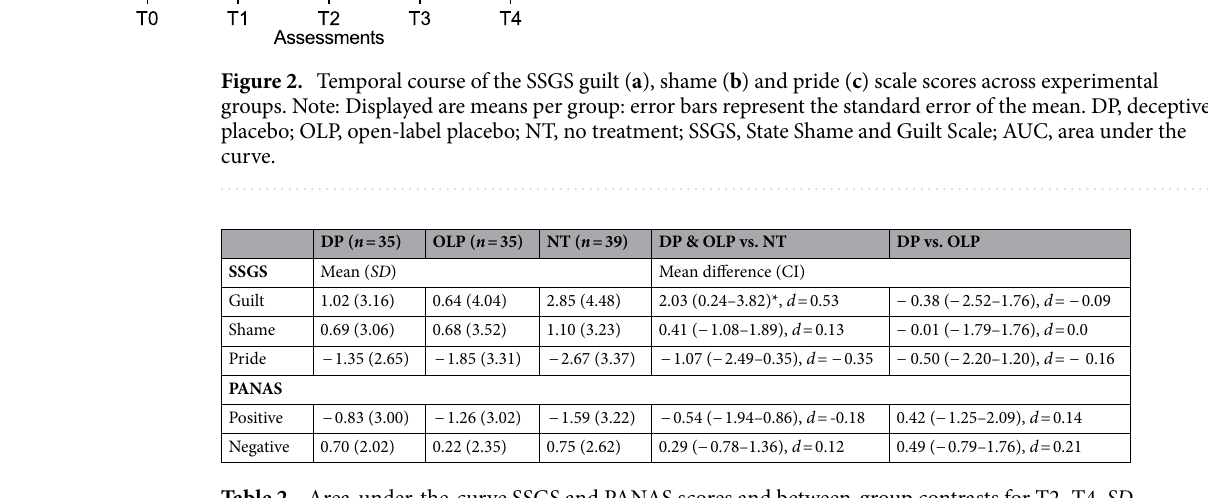
Table 2. Area-under-the-curve SSGS and PANAS scores and between-group contrasts for T2–T4. SD , standard deviation; DP, deceptive placebo; OLP, open-label placebo; NT, no treatment; SSGS, State Shame and Guilt Scale; AUCi, area under the curve with respect to increase; CI, confidence interval, * p < 0.05.